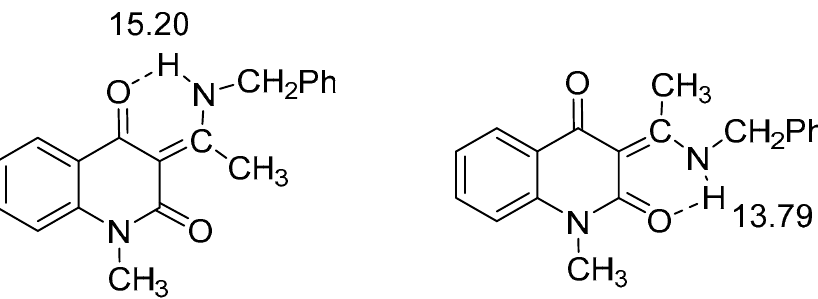
Figure 7. Comparison of ketone and amide groups as acceptors. Data from [30]. The numbers are the NH chemical shifts in ppm.